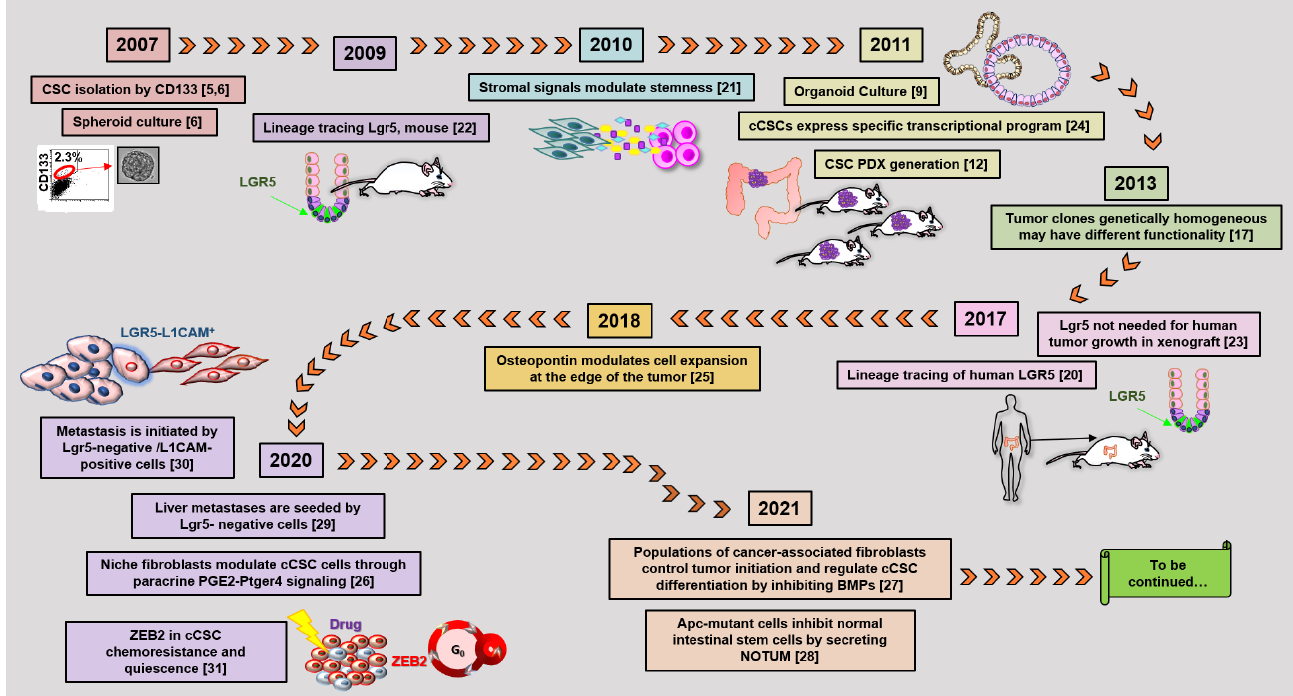
Figure 2. The timetable of landmark studies that have contributed to defining cCSC biological features and functions. Numbers in parentheses indicate references [5,6,9,12,17,20 – 31].